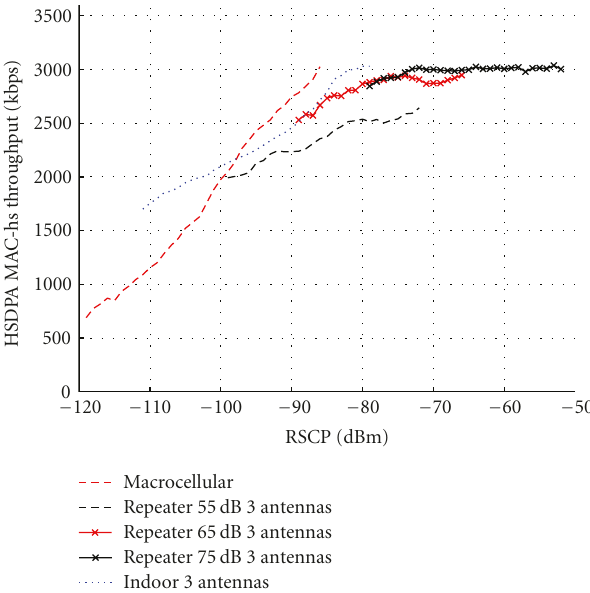
Figure 8: Average of all TP samples for each RSCP value, open area. Macrocellular, repeater and indoor systems, 3 antenna